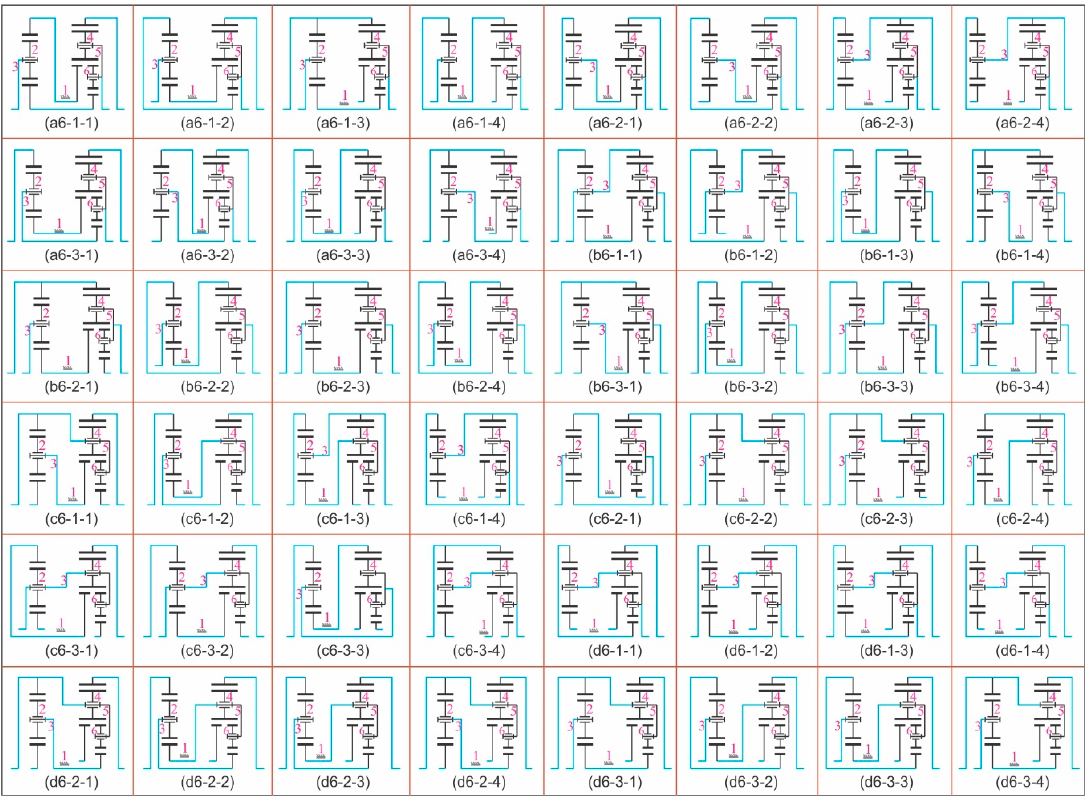
Figure 10. Atlas of transmission mechanism designs.